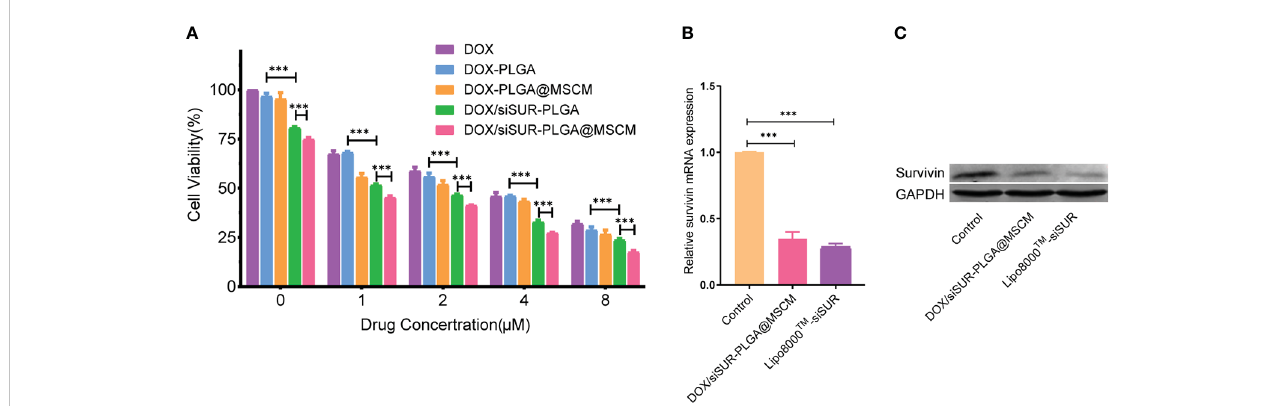
FIGURE 4 Evaluation of the cytotoxicity and gene-silencing ef fi ciency of the nanoparticles. (A) Viability of MG63 cells after treatment with various nanoparticles containing DOX at different concentrations. MG63 cells were transfected with siRNA using Lipo8000 ™ or treated with DOX/siSUR-PLGA@MSCM nanoparticles containing the same concentration of siRNA, and the gene and protein expression of survivin was determined by qRT − PCR (B) and western blotting (C) , respectively. ***p <0.001,